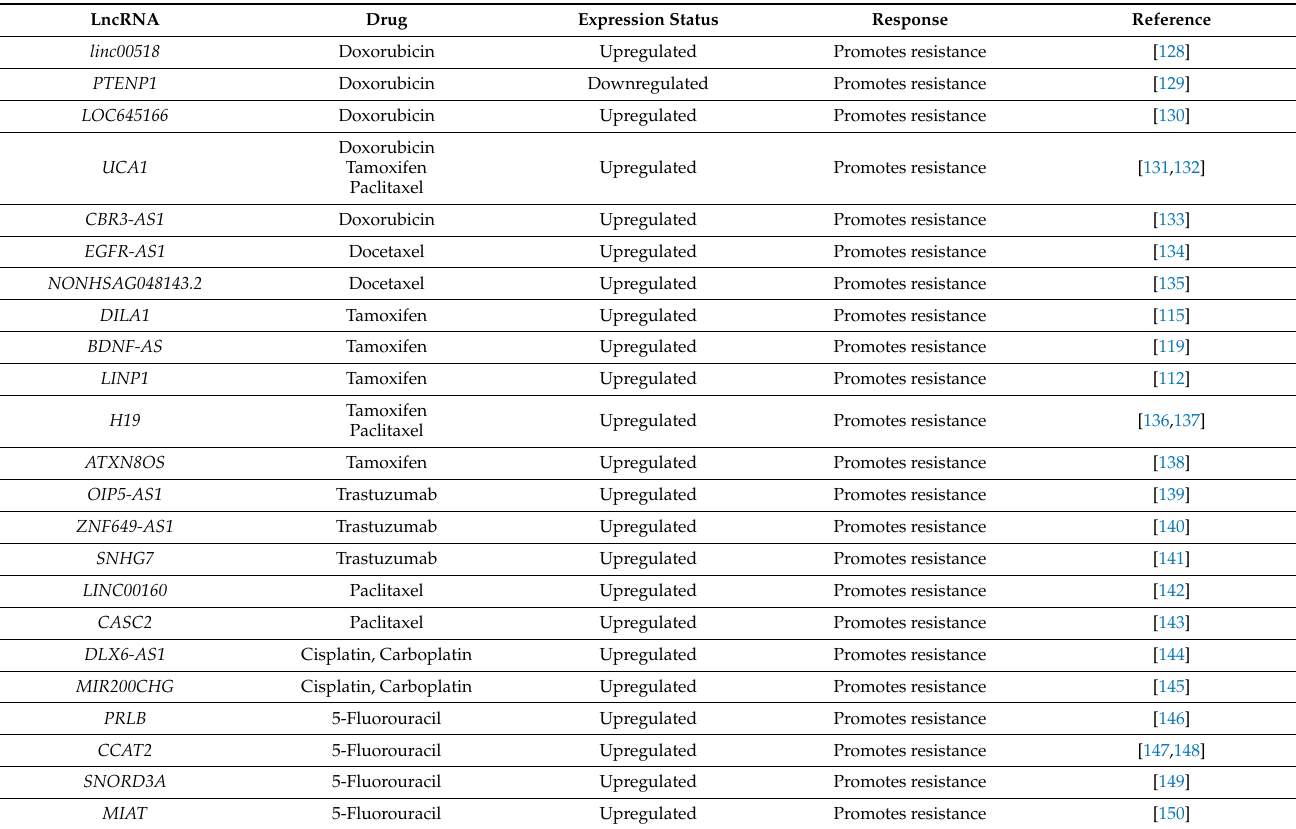
Table 2. Studies in mouse models for lncRNA biomarker discovery in breast